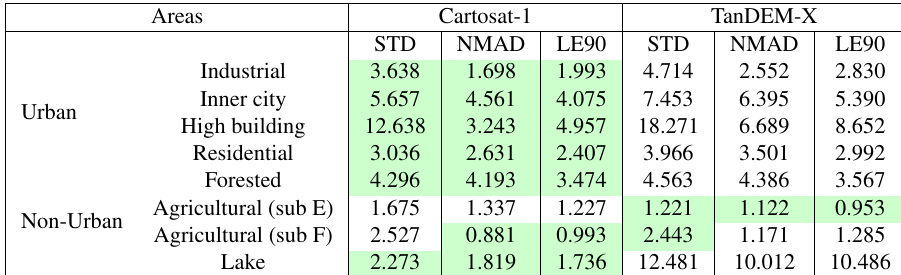
Table 1. Height accuracy (in meter) of TanDEM-X and Cartosat-1 over different areas